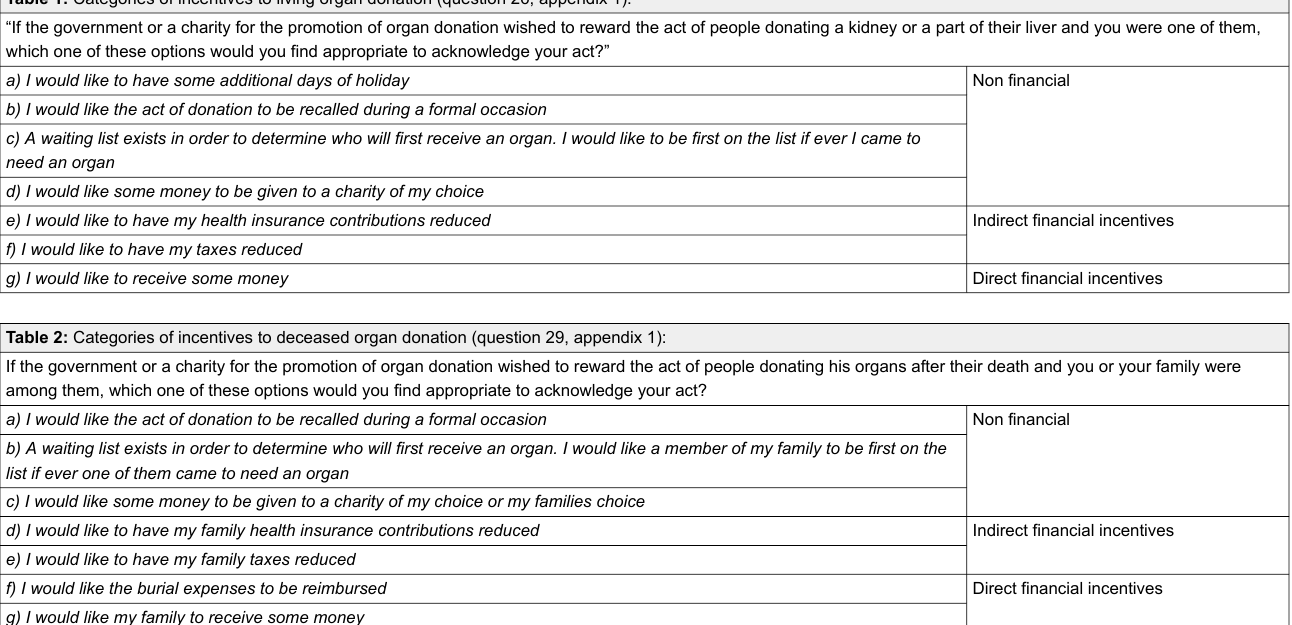
Table 2: Categories of incentives to deceased organ donation (question 29, appendix